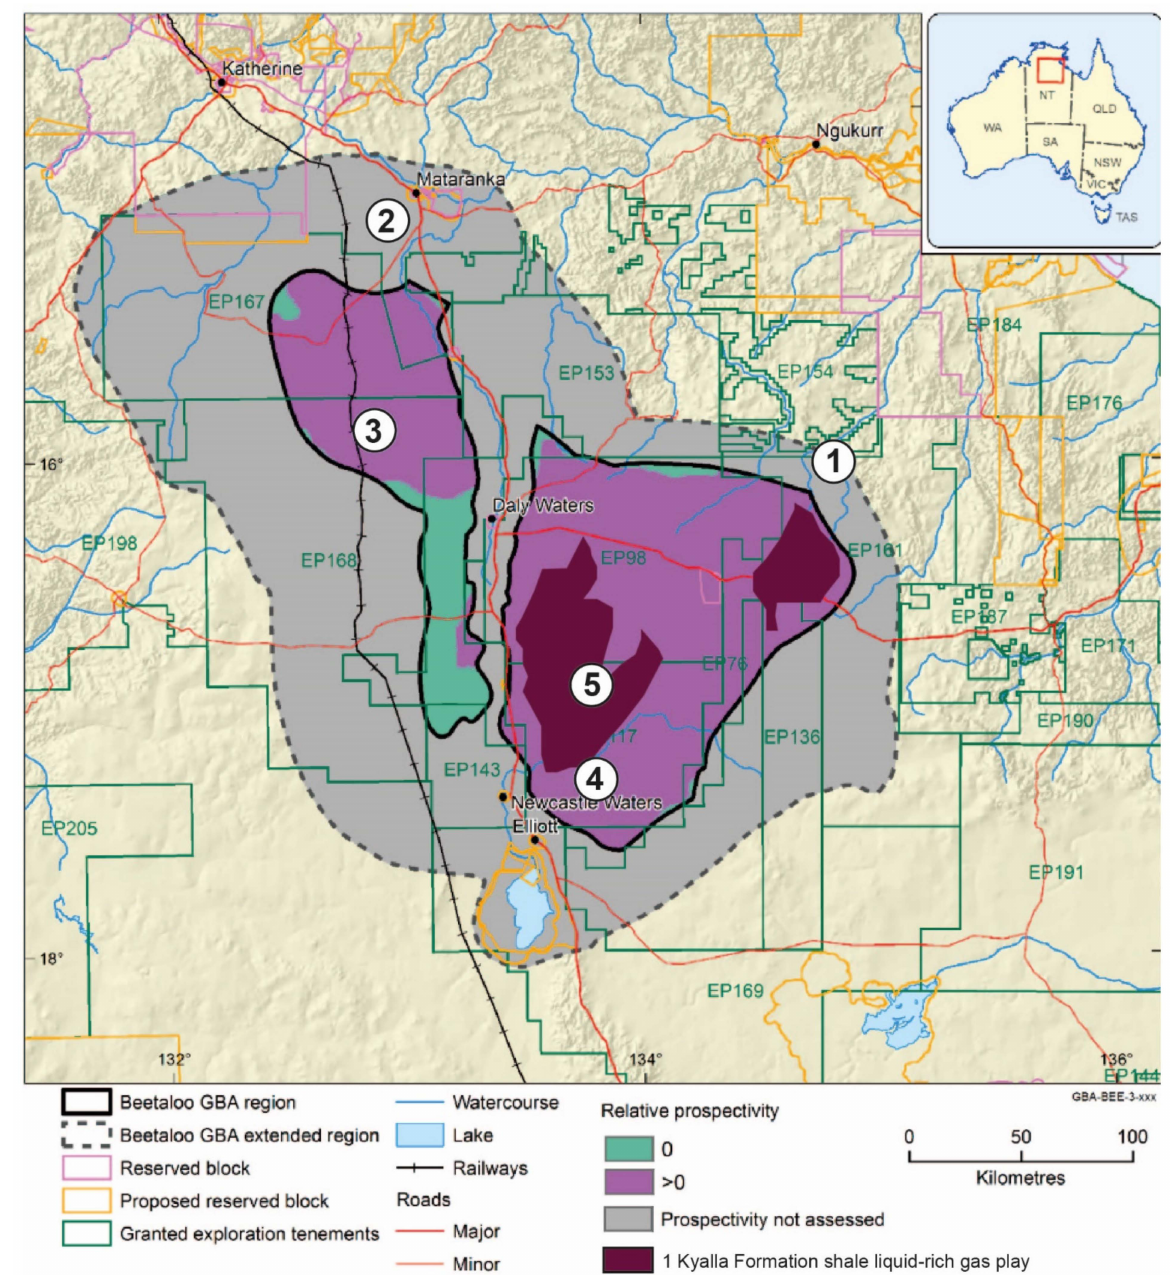
Figure 10. Unconventional petroleum prospectivity (27; 12) and potential current and post-Cambrian paleo fluid flow (1 to 5) associated with fault pathways. Compilation of datasets from this article. 1 OT Downs fault zone, 2. Mataranka and Birdum Creek Fault, 3. Western Beetaloo Sub-basin, 4. southern part of the eastern Beetaloo Sub-basin, 5. Central part of the eastern Beetaloo